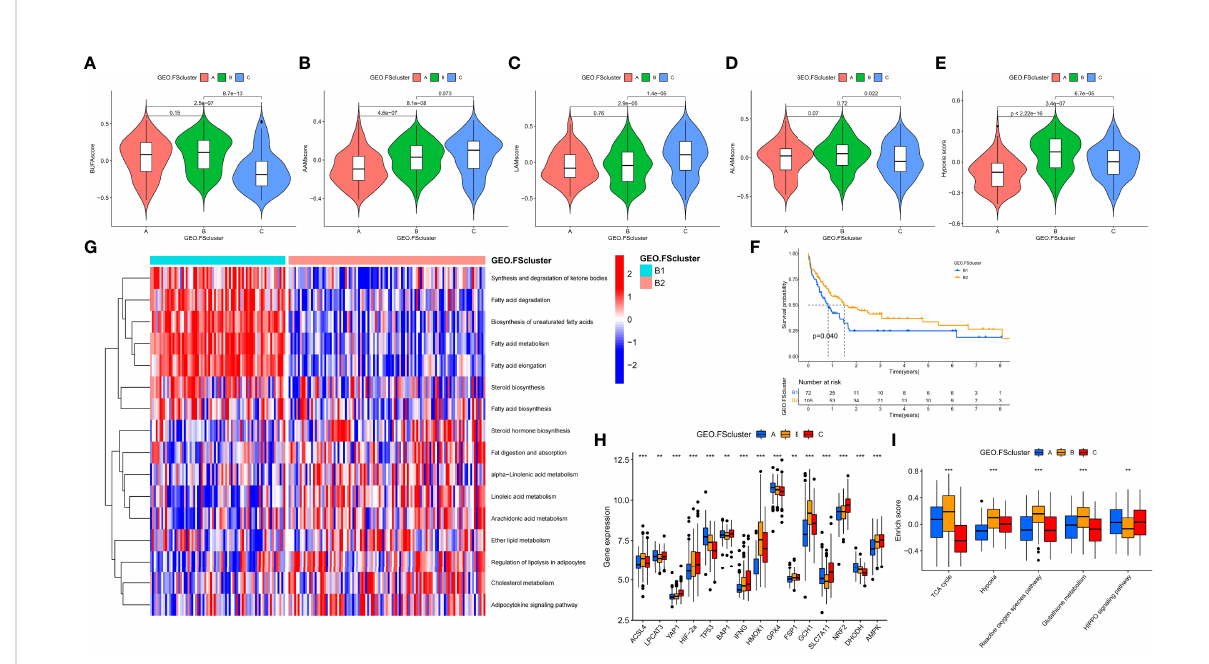
FIGURE 3 Analysis of the metabolic characteristics of unsaturated fatty acids in ferroptosis-related molecular patterns and other factors affecting ferroptosis. (A – E) Differences in BUFAscore, AAMscore, LAMscore, ALAMscore, and hypoxia score in different ferroptosis-related molecular pattern groups in the GEO cohort, Kruskal – Wallis test. (F) Kaplan – Meier survival analysis of different cluster subtypes in the FScluster B of the GEO group, log rank test. (G) GSVA showed the activation levels of lipid metabolism pathways in different cluster subtypes. FScluster B of the GEO group. (H, I) Differences in genes and signaling pathways that affect ferroptosis among different ferroptosis-related molecular patterns, Kruskal – Wallis test, **P < 0.01; ***P <